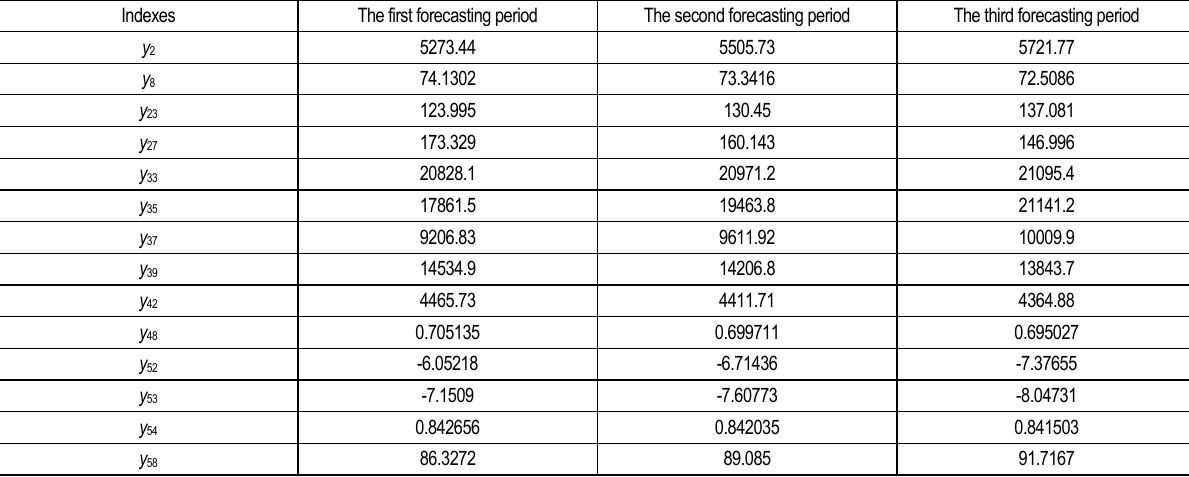
Table 10. Forecasting meanings of indexes characterizing integration processes of Ukraine Indexes